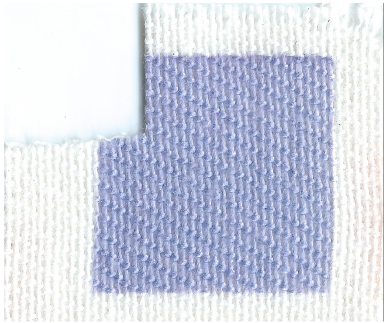
Figure 1. Square pattern printed with CTAB-based ink, on cotton.